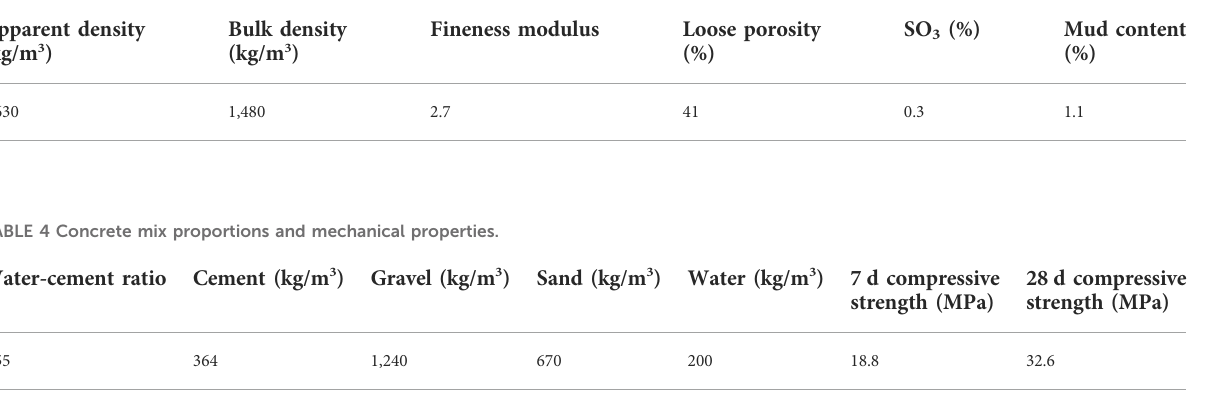
TABLE 3 Basic parameters of sand.